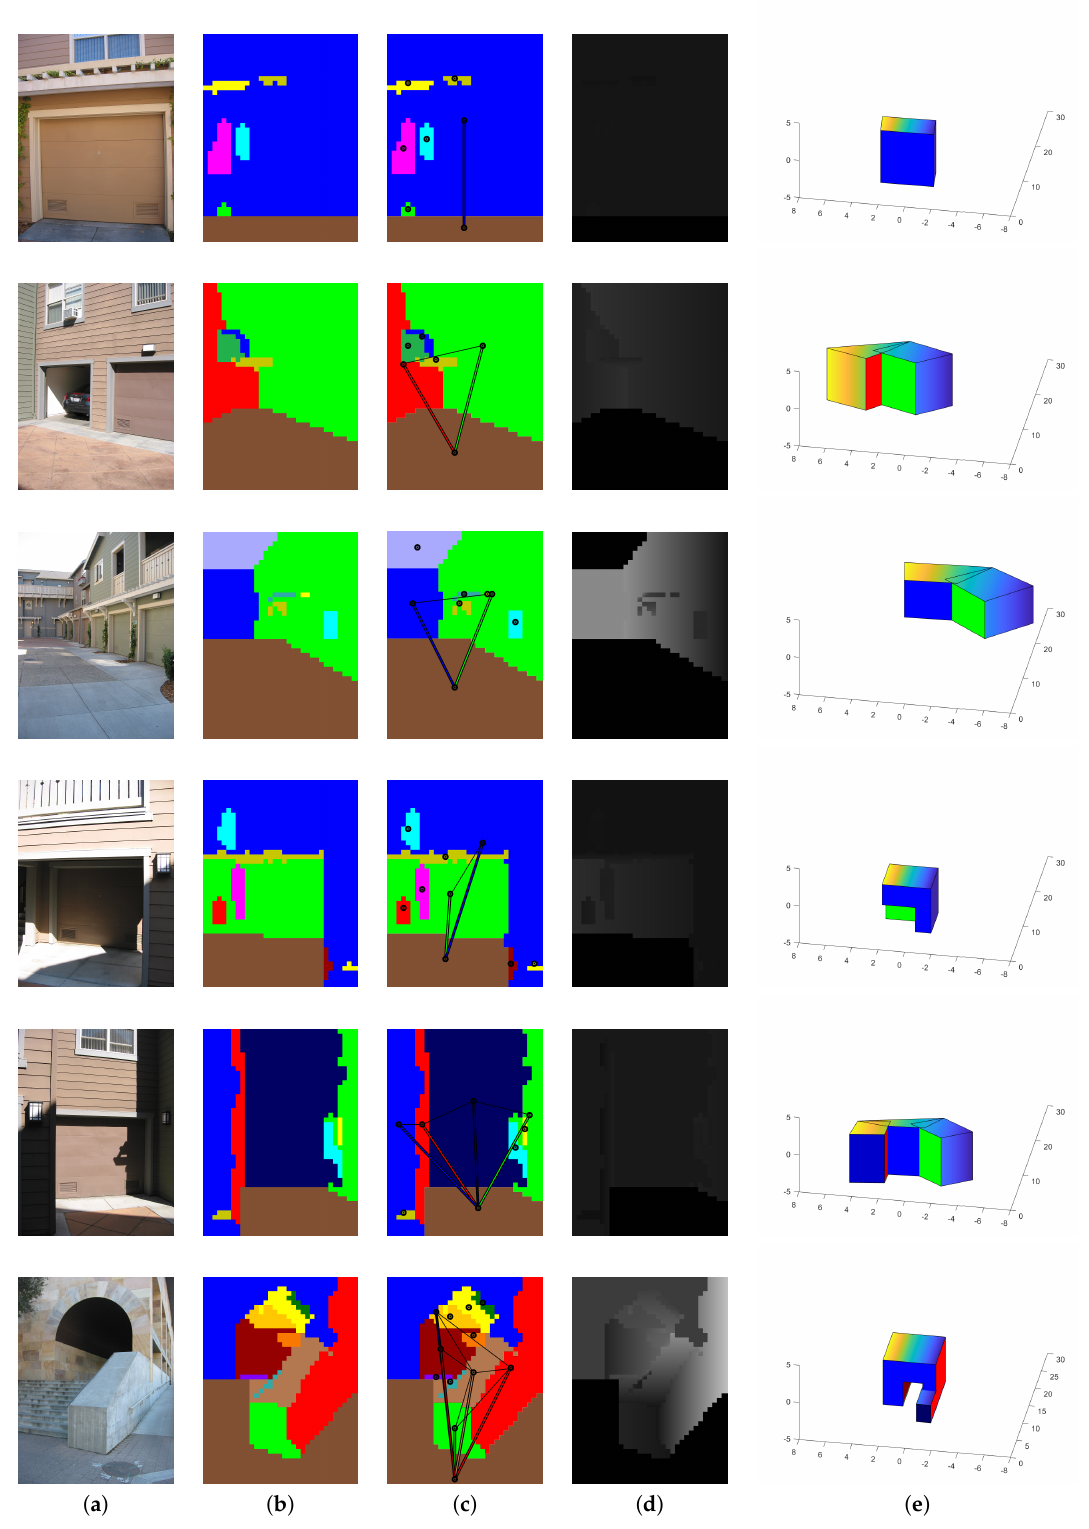
Figure 9. Our HLS extraction method on the Make3D dataset. ( a ) Input image; ( b ) Orientation segmentation; ( c ) Graph analysis; ( d ) Our depth; ( e ) HLS